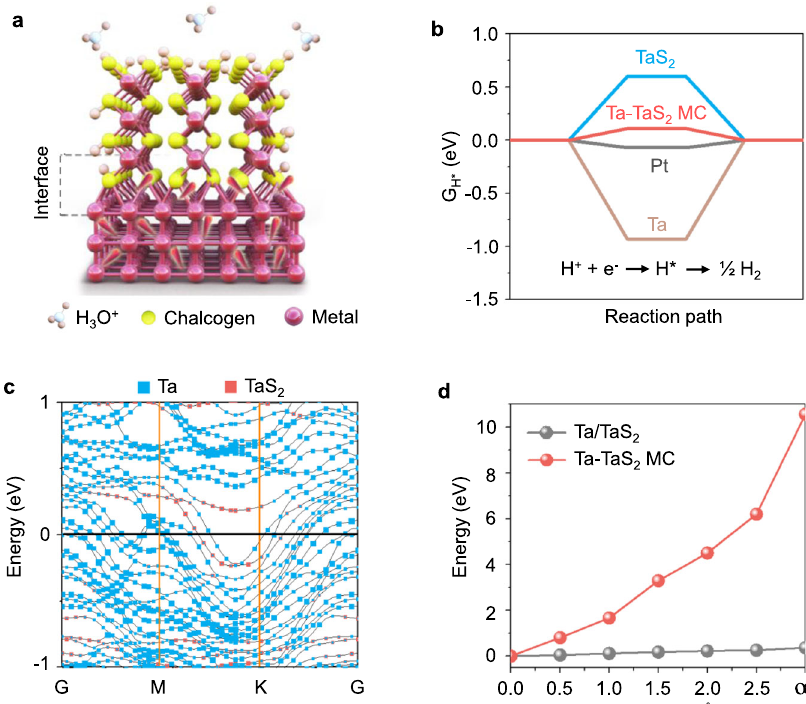
Fig. 1 Structure and properties of the Ta-TaS 2 MC material. a Atomic structure of the Ta-TaS 2 MC. b Hydrogen absorption free energy diagram of Ta, TaS 2 , Ta-TaS 2 MC, and Pt catalysts. c Its band structures. d The separation energies of Ta and TaS 2 in parallel Ta/TaS 2 and vertical Ta-TaS 2 MC